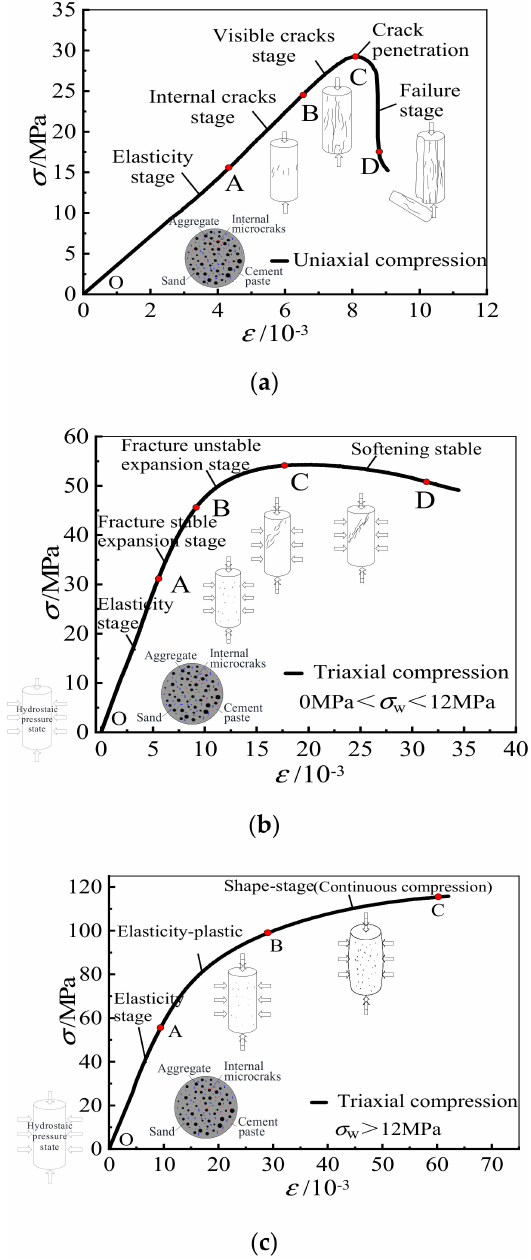
Figure 10. Failure process of specimens. ( a ) Failure process of stress-strain curve under uniaxial com- pression. ( b ) Failure process of stress-strain curve under triaxial compression (0 MPa < σ w ≤ 12 MPa). ( c ) Failure process of stress-strain curve under triaxial compression ( σ w > 12